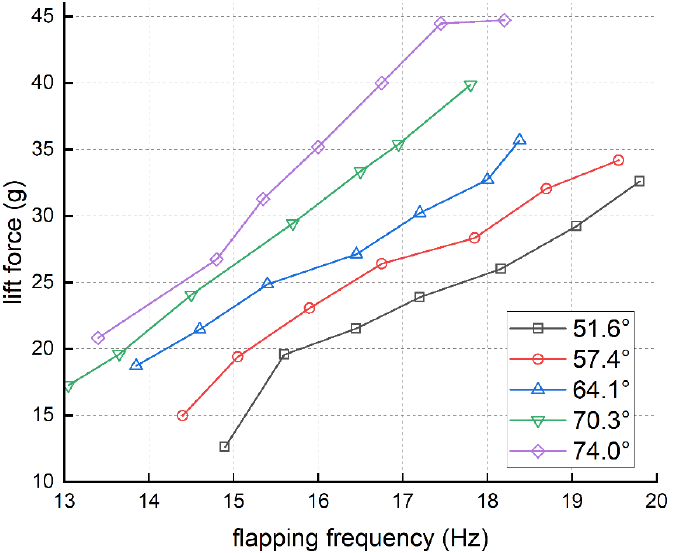
Figure 22. The flapping frequency-lift force line chart of the FWR with different flapping amplitudes.